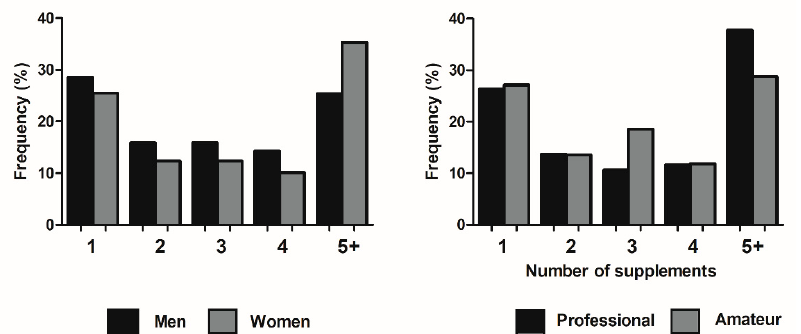
Figure 1. Number of supplements consumed according to sex (left panel) and competitive level (right panel). Data are mean ± standard deviation for 112 players who reported the use of at least one supplement in the questionnaire.